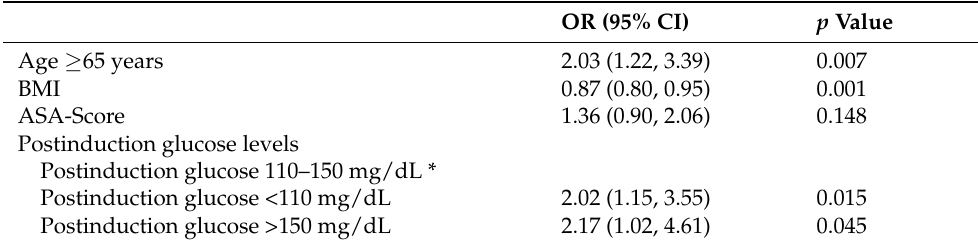
Table 3. Multivariable logistic regression model analyzing predictors for